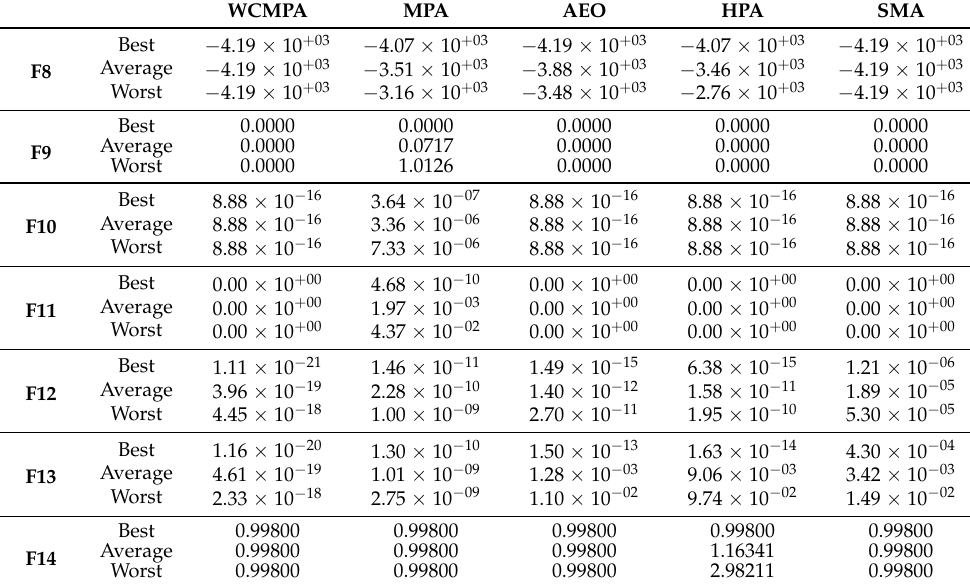
Table 3. Parametric test values for multimodal benchmark functions.